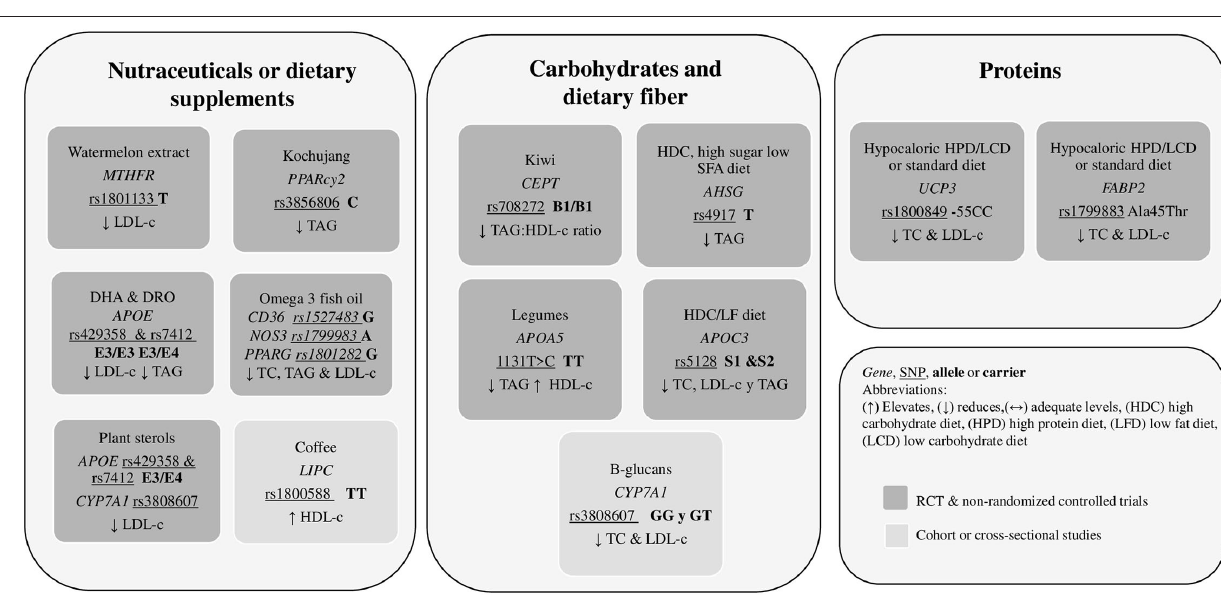
FIGURE 3 | Dietary recommendations related to gene variants and diet